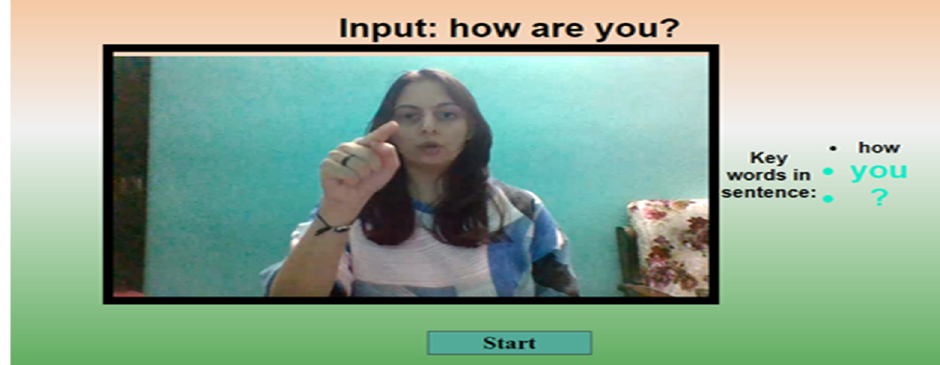
Figure 20. Case 9. Available video for ‘you’.